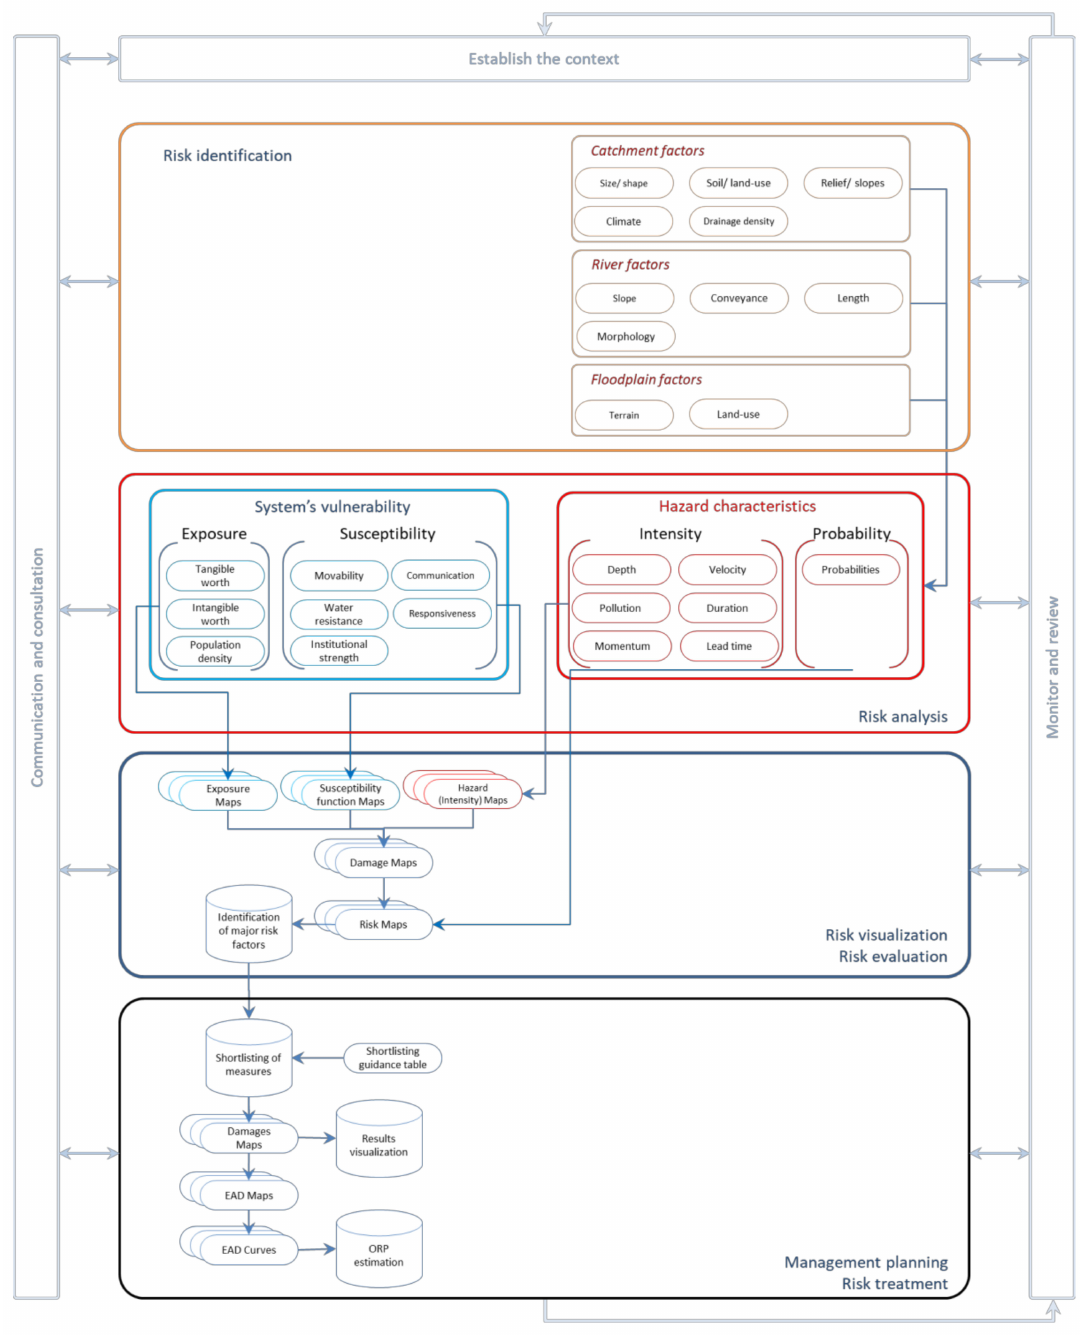
Figure 1. The proposed basic framework for risk-based flood management fitted into the context of ISO Guide 31000